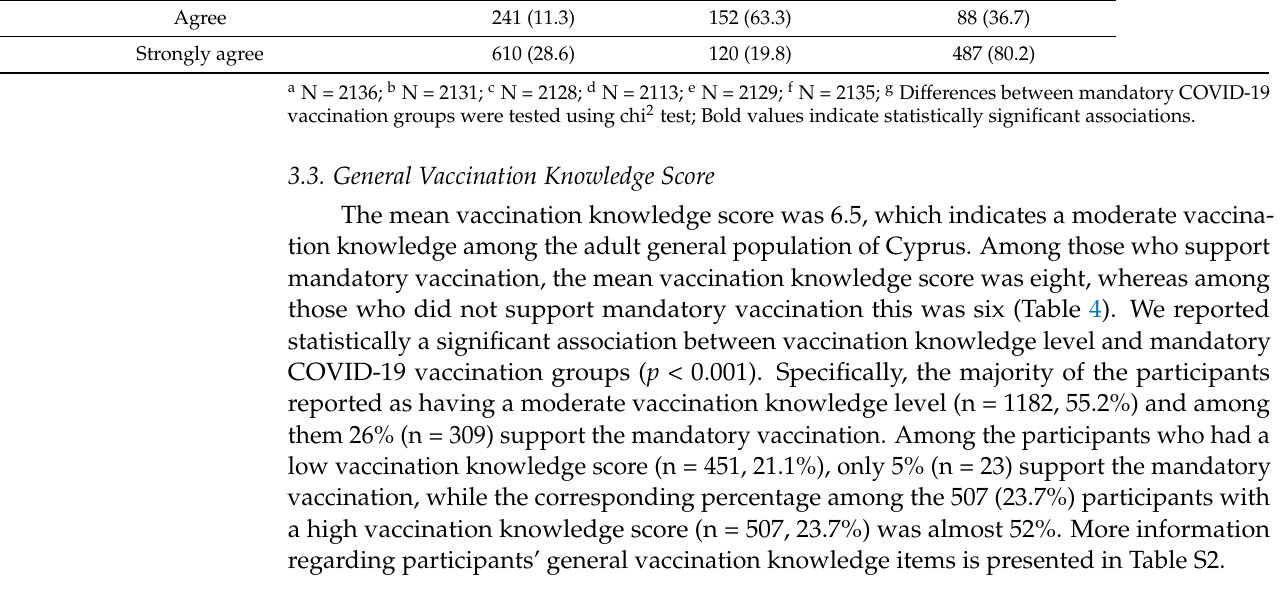
Table 4. Participants’ general vaccination knowledge, overall and by mandatory vaccination